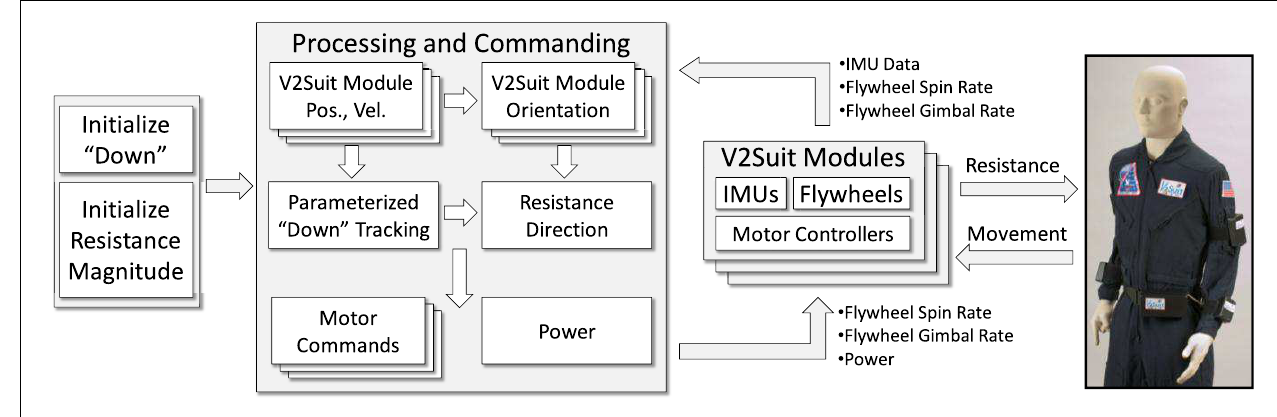
FIGURE 1 | High level V2Suit system